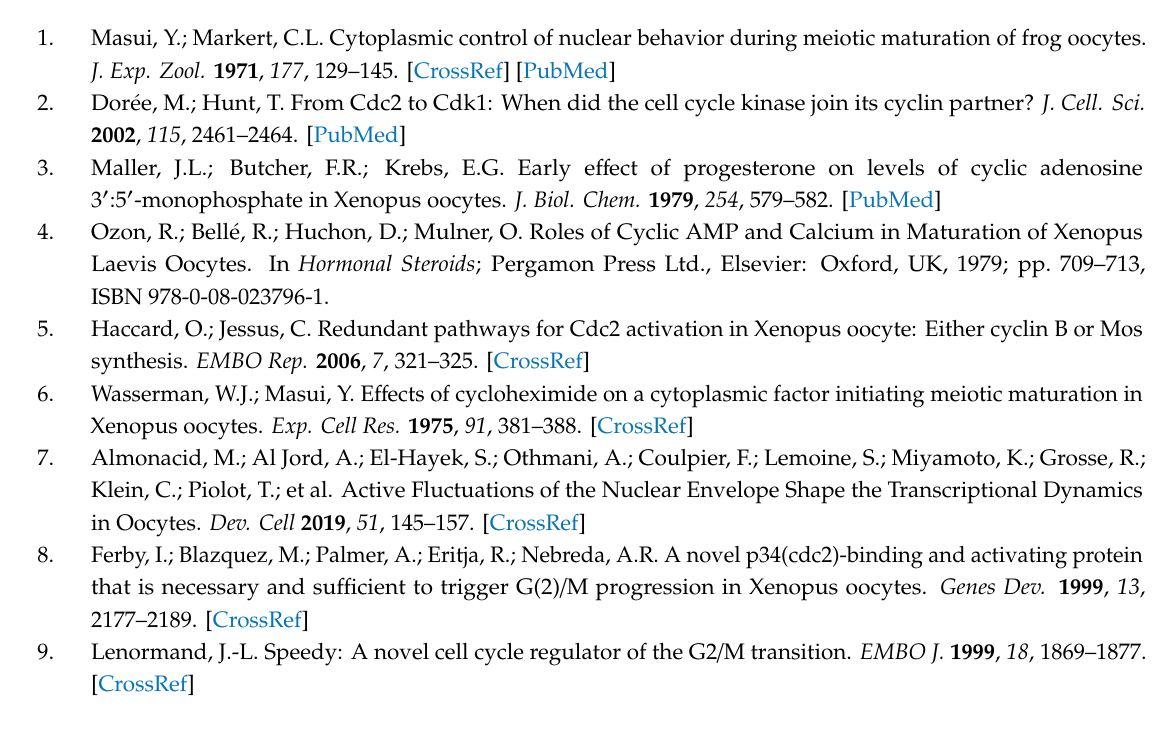
Figure S1: Genome-wide analysis of fully-grown oocytes stimulated or not by progesterone for 90 minutes, Figure S2: Changes in translation e ffi ciency during meiosis resumption and